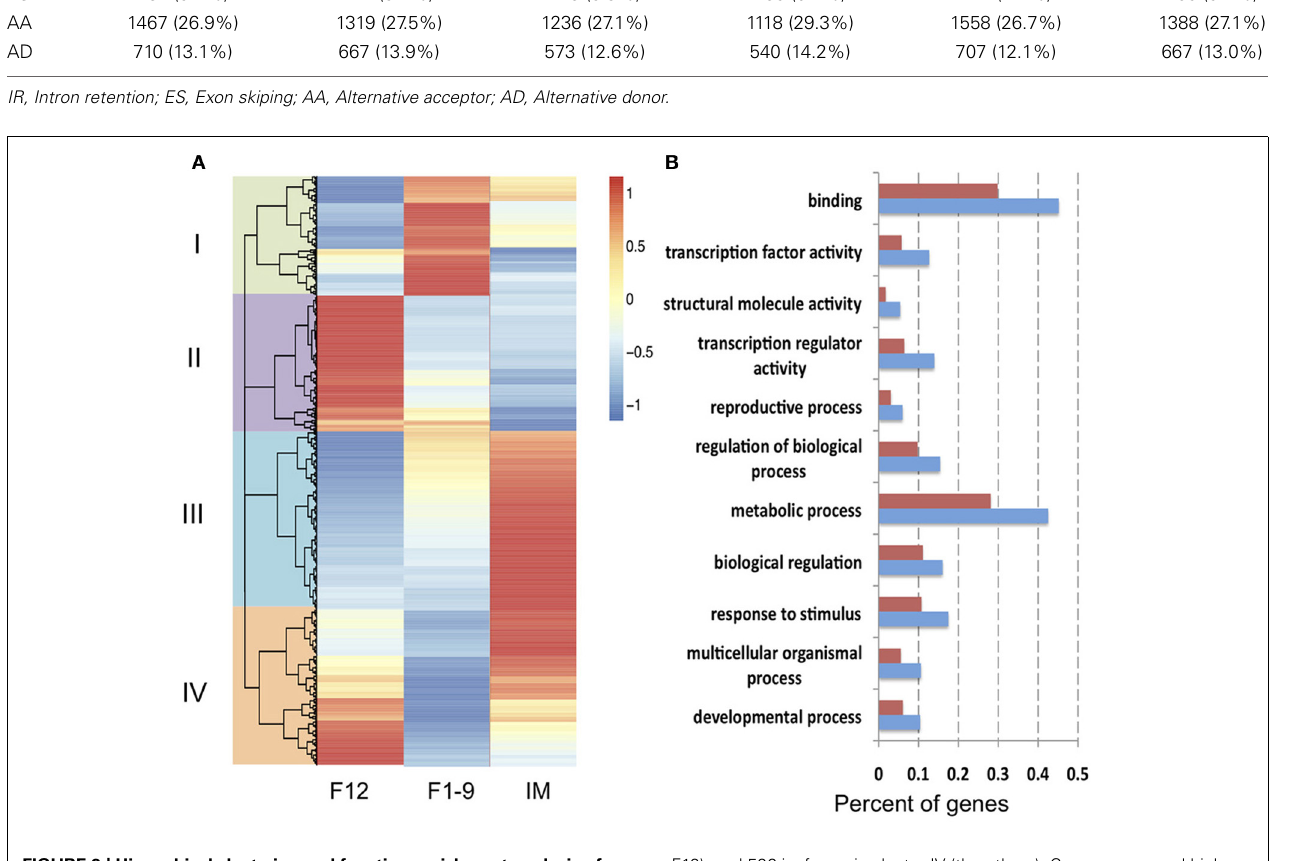
FIGURE 3 | Hierarchical clustering and function enrichment analysis of 1716 differentially expressed isoforms among three stages. (A) Differentially expressed isoforms were clustered into four clusters: 359 isoforms in cluster I (with expression values as F1–9 > IM > F12), 460 isoforms in cluster II (F12 > F1–9 > IM), 401 isoforms in cluster III (IM > F1–9